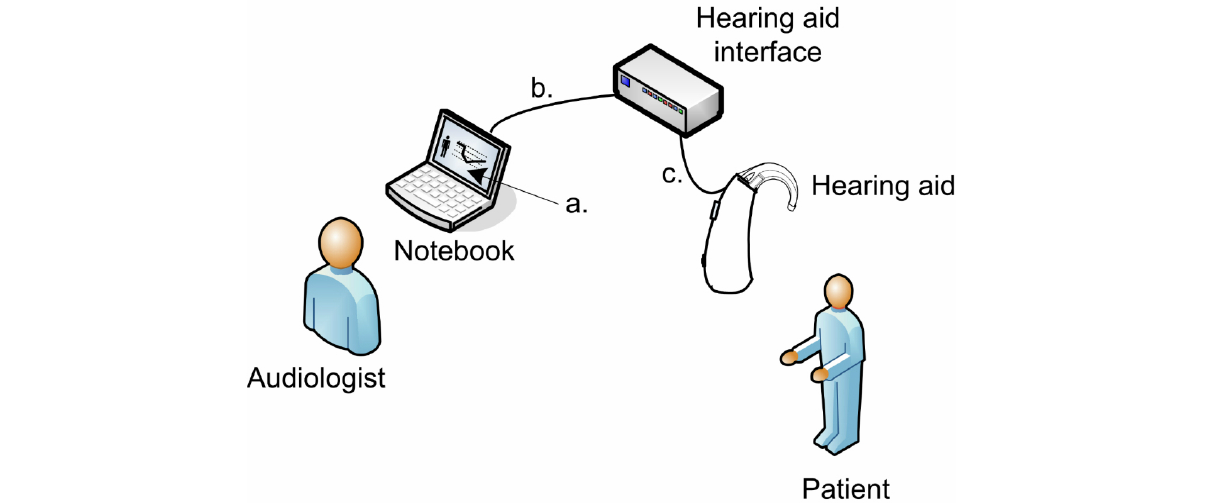
Figure 1. Diagram of a basic adjustment with digital